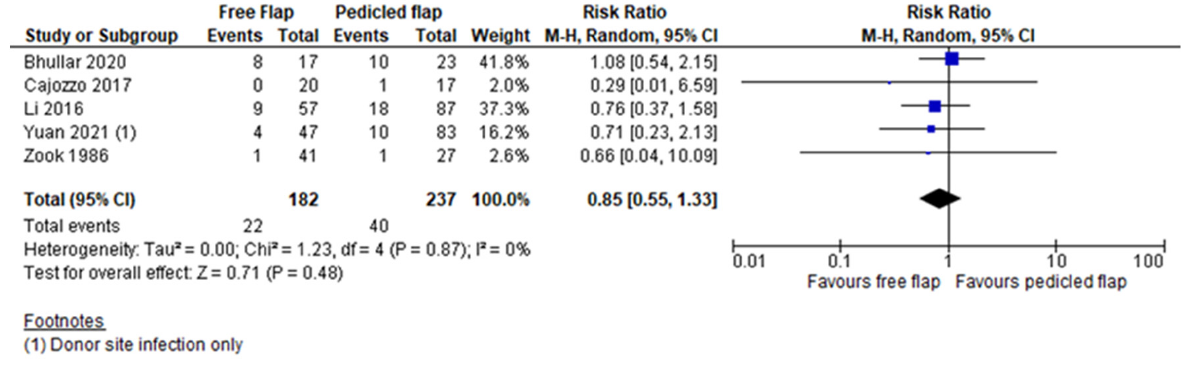
Figure 6. Patient high aesthetic satisfaction meta-analysis [13,14,19].